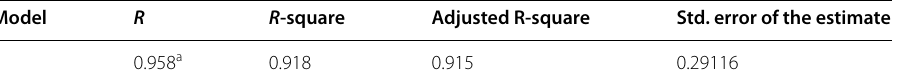
Table 10 Model summary b